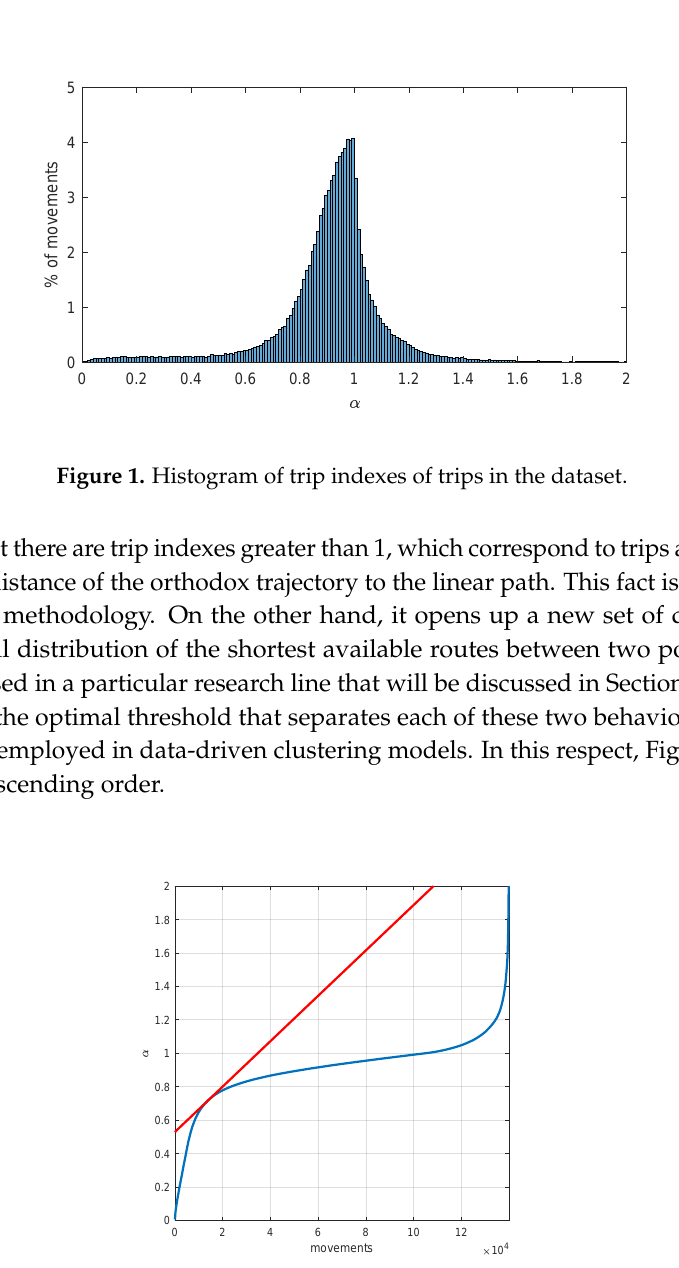
Figure 2. In blue: trip indexes sorted in ascending order; in red: the tangent line obtained by the elbow method. The optimal value for the threshold of the trip index is α ∗ = 0.7. We then use this value to classify trips as transport or